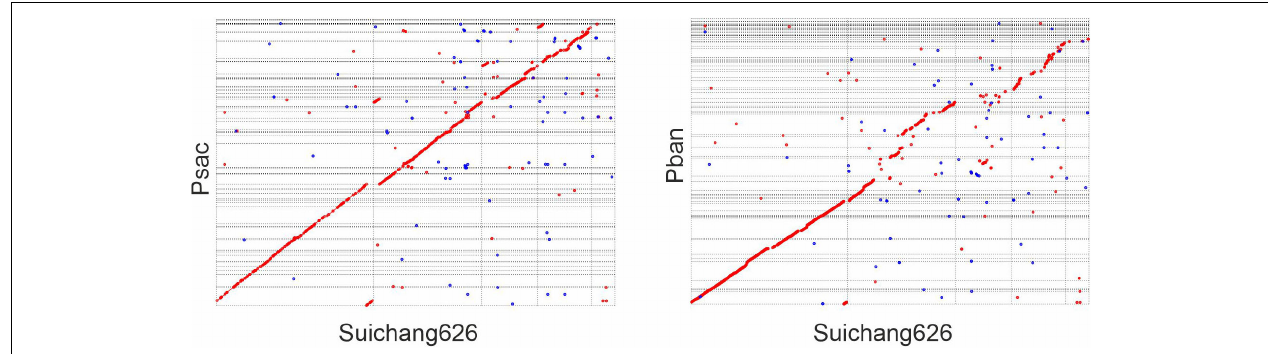
FIGURE 3 | Dot-plot of whole genome alignment between Paraburkholderia sacchari Suichang626 and P. sacchari LMG19450 (Psac), and between P. sacchari Suichang626 and P. bannensis (Pban). Mummer 4.0.0beta2 (nucmer) was used for genome assembly comparison. Forward alignment was ploted in red and reverse as blue. Optimal co-linear order of contigs was shaped with mummerplot with parameter –fat. Mummerplot output.ps files were viewed and edited in